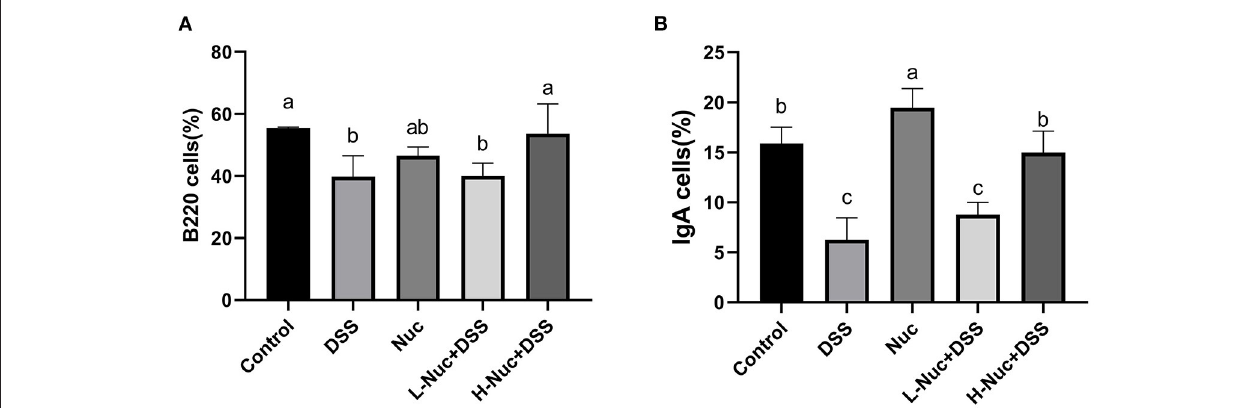
FIGURE 2 | Effects of nuciferine on B cell, (A) The percentage of B220 cells in the PP nodes. (B) The percentage of IgA cells in the PP nodes ( n = 6). The dataare expressed as the mean ± S.D. Significant differences were considered at P < 0.05. a − c Bars without the same superscripts differ significantly ( P < 0.05).